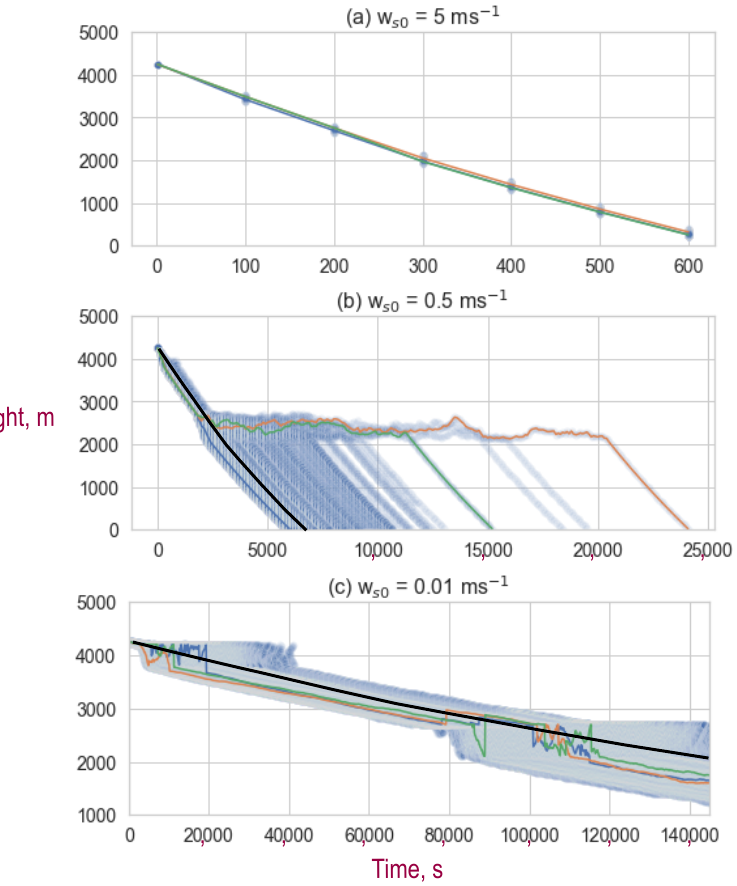
Figure 4. Longitudinal time-section through Lagrangian dispersion model showing paths of volcanic particles settling through turbulent layers, in which suspension is enhanced. This output is based on layers in Figure 3. See Table 4. Most particles colored semitransparent blue, so deeper hue means more particles. A few separate particles are colored differently to show individual paths. In ( b ) and ( c ), the black particle path is for particle falling at effective settling speed. ( a ) 4 mm particles not affected by turbulence (Table 3). ( b ) 250 µ m particles are sometimes affected by turbulence, and can remain intermittently suspended in more turbulent layers. ( c ) 30 µ m particles are profoundly affected by variations in turbulence intensity.